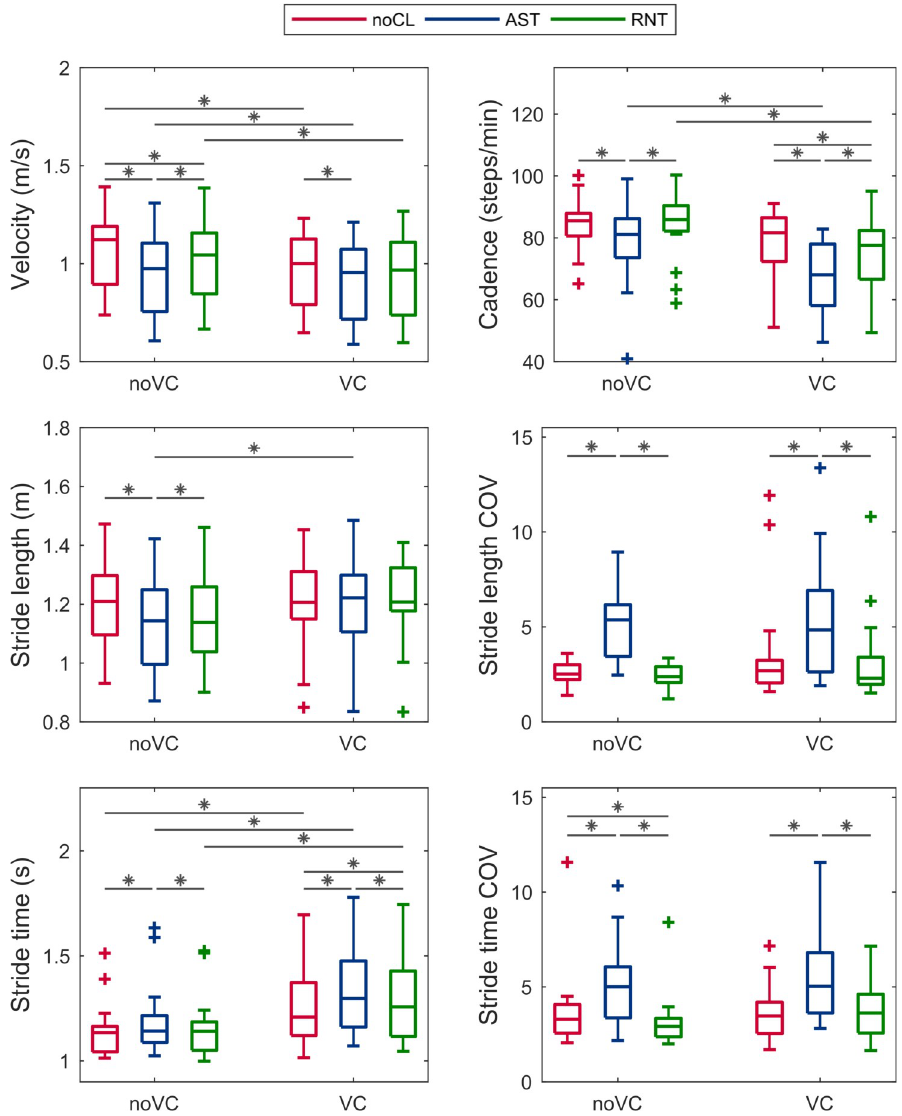
Fig 2. Gait parameters under different conditions of Experiment 1. Boxplots of the gait velocity (m/s), cadence (steps/min), stride length (m), stride length coefficient of variation (COV), stride time (sec), and stride time coefficient of variation (COV). Cognitive load conditions are illustrated in red (control cognitive load, noCL), blue (Auditory Stroop Task, AST), and green (Random Numbers Task, RNT). Conditions with no visual cues (‘noVC’) are displayed at the left sides of the plots, conditions with visual cues (‘VC’) at the right sides. Asterisks above indicate significant differences between cognitive load conditions (within the left or right half of a plot), and between visual cueing conditions (crossing the midline of the